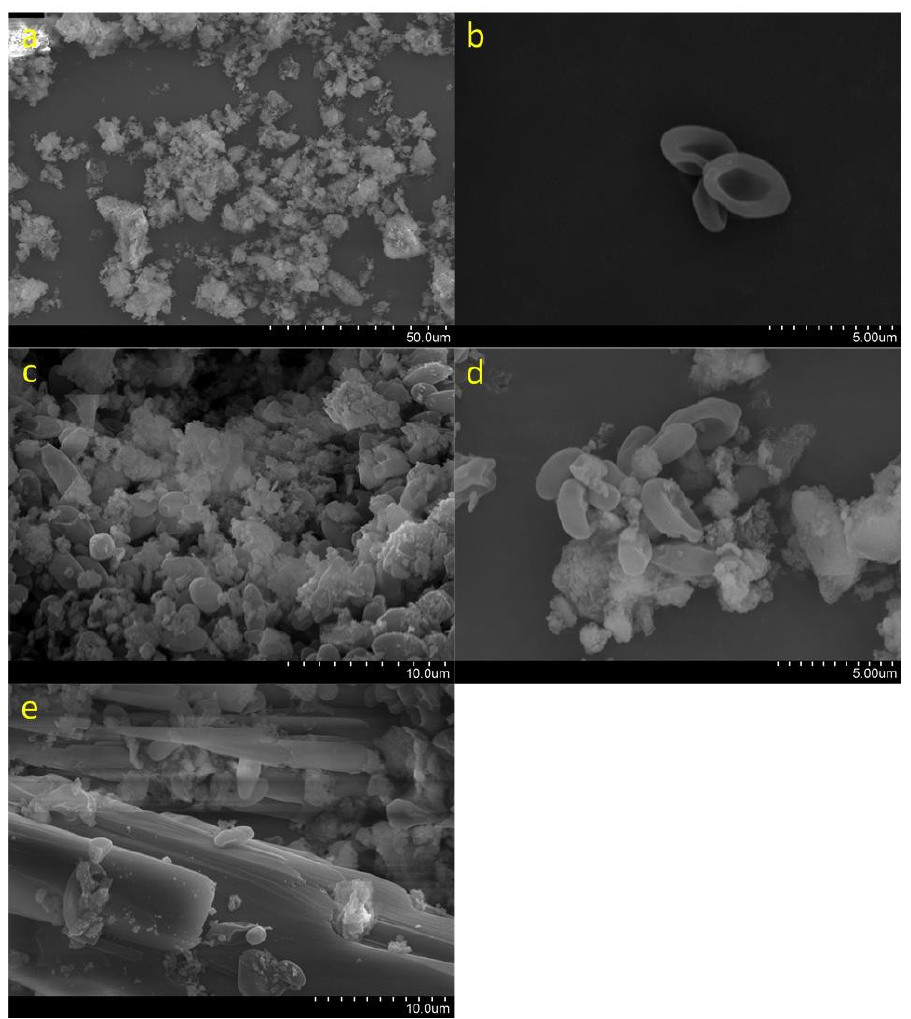
Figure 6. SEM images of ( a ) raw RM, ( b ) Acetobacter sp., ( c ) cells of Acetobacter sp. adhering to RM under one-step process, ( d ) bacterial cells and RM aggregates, and ( e ) recrystallization during bacterial bioleaching.